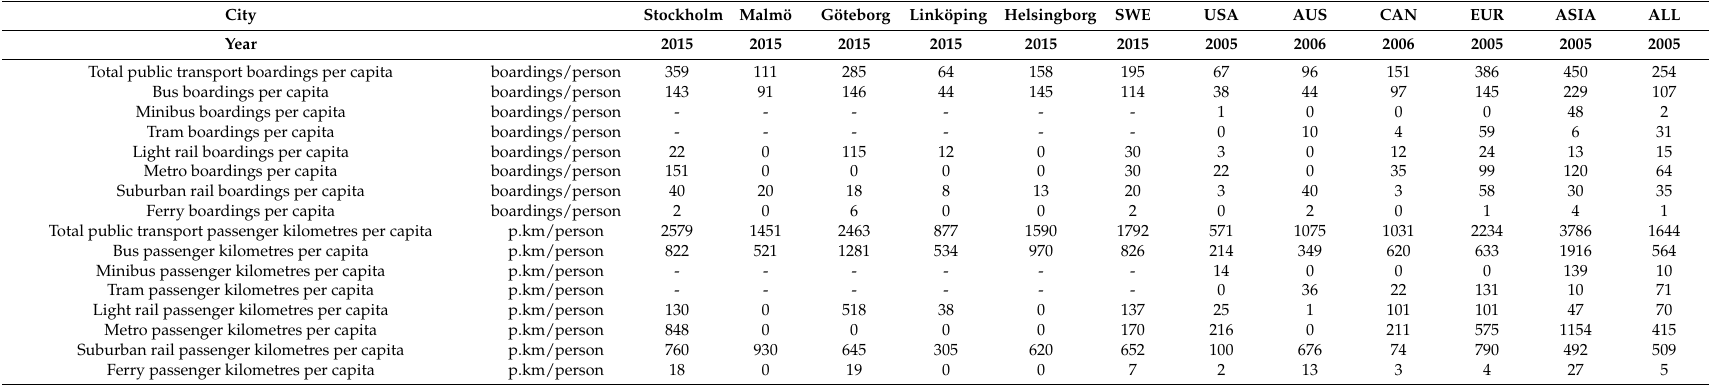
Table 6. Public transport use in Swedish and international